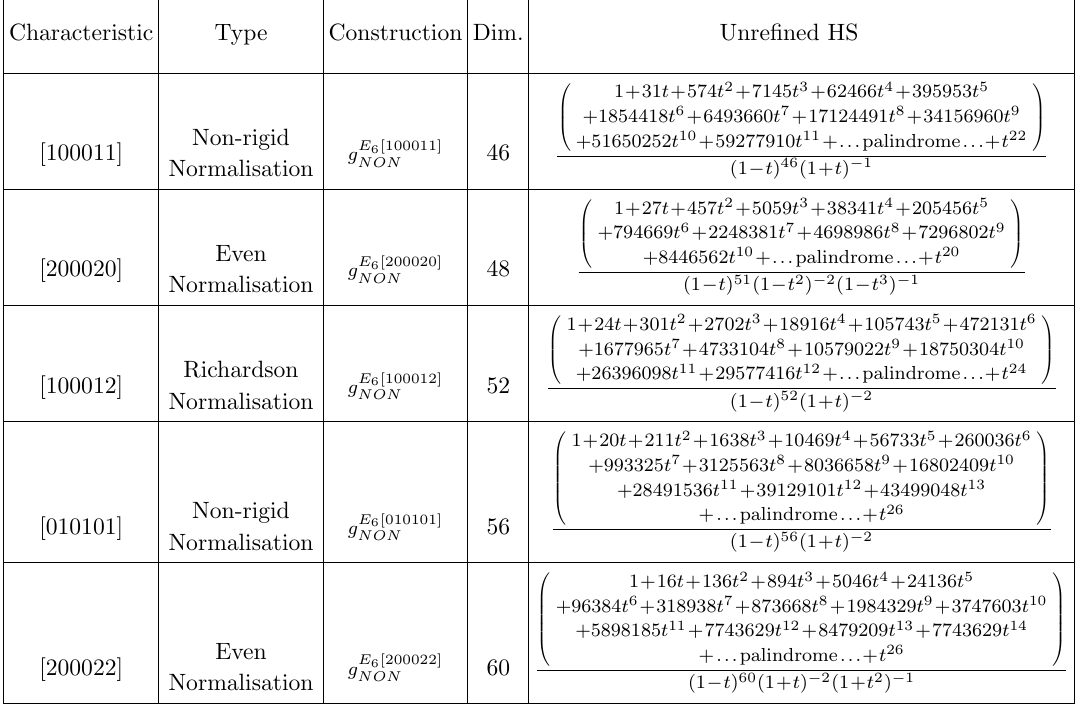
Table 15 . E 6 nilpotent orbit normalisations and Hilbert series.